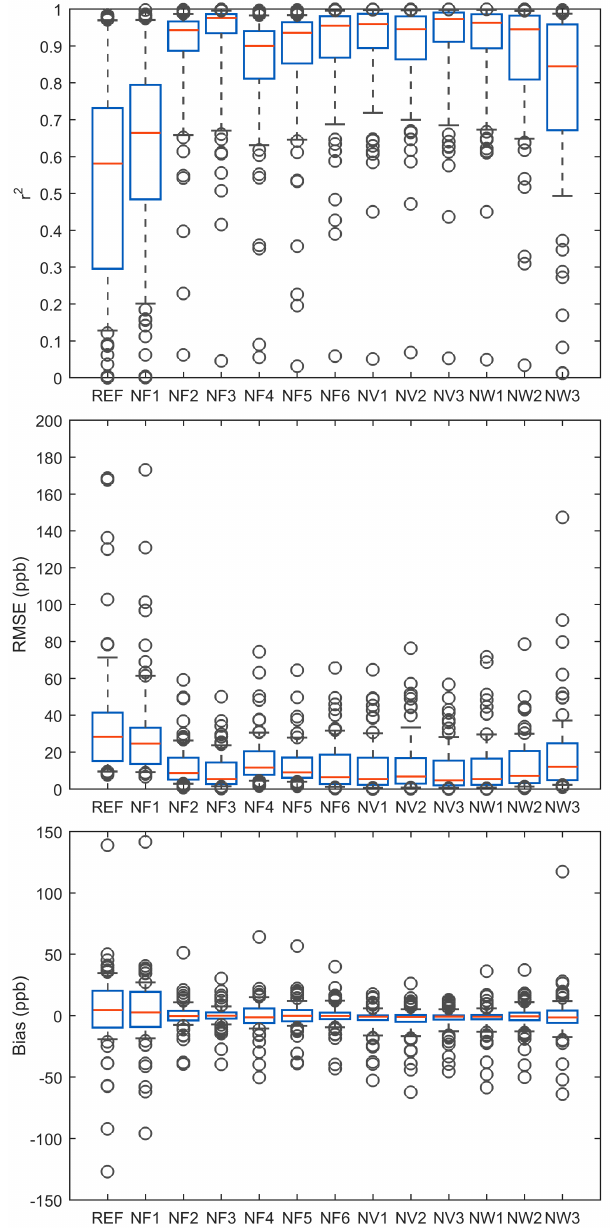
Figure 4. FLEXPART CTM model performance based on boxplots of coefficient of determination, root mean square error (RMSE) and bias in daily average methane model fractions at surface stations for different kernel settings (see Table 1). Independent validation sta- tions are included. The red line in the boxplots indicates the median, the bottom and top box edges are the 25th and 75th percentiles, and whisker ends are at 9th and 91st percentiles. The circles are